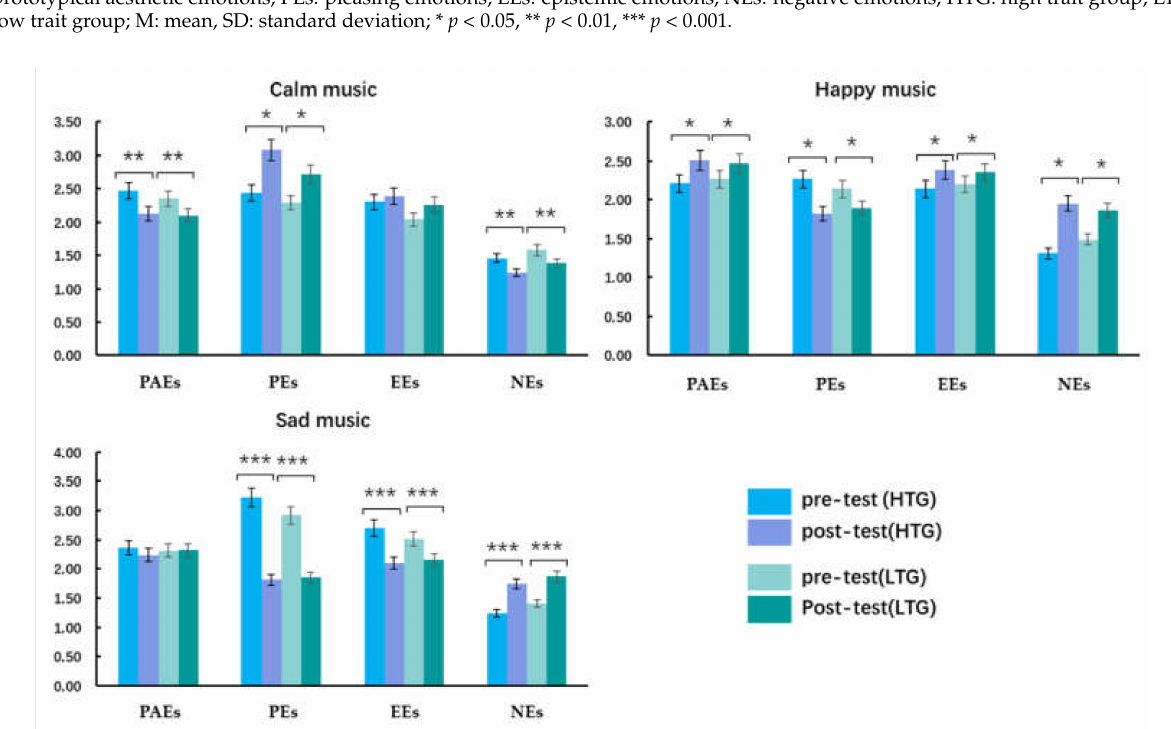
Figure 4. Aesthetic Emotions Scale (AETHEMOS) differences within- and between-group on the three levels of musical emotion. PAEs: prototypical aesthetic emotions, PEs: pleasing emotions, EEs: epistemic emotions, NEs: negative emotions; HTG: high trait group, LTG: low trait group; M: mean, SD: standard deviation; * p < 0.05, ** p < 0.01, *** p <